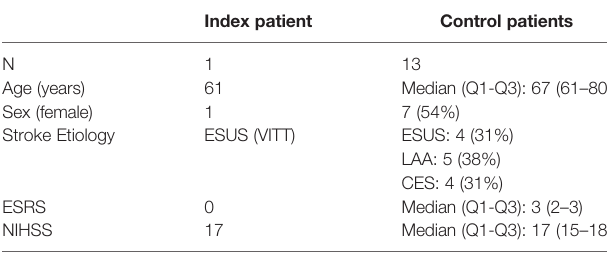
TABLE 1 | Clinical characteristics of the study